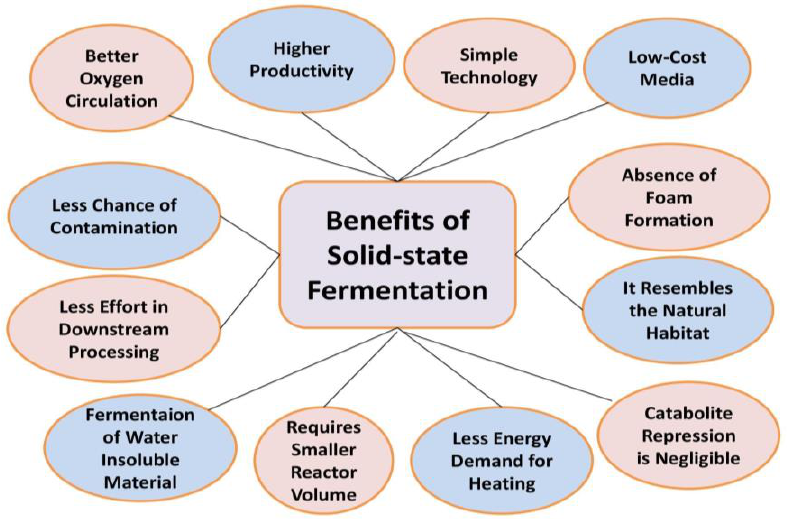
Figure 2. The benefits of Solid-state fermentation.